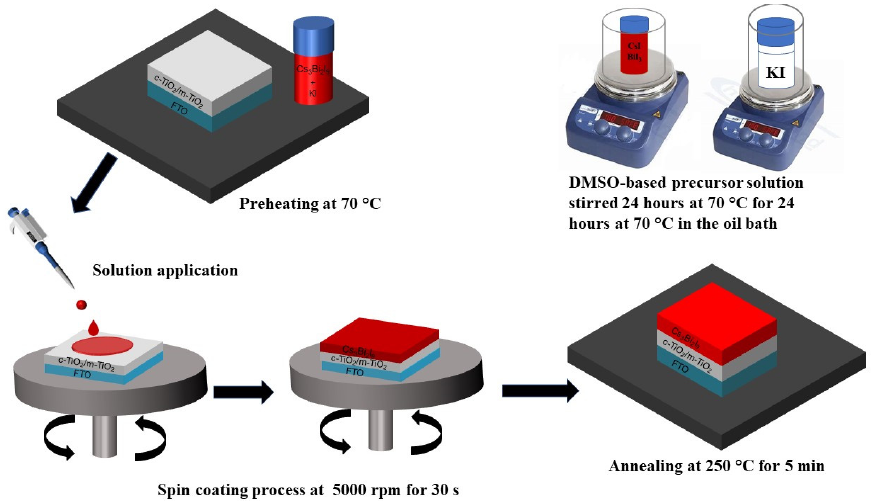
Figure 1. Schematic illustration of the conventional spin-coating process for preparing the Cs 3 Bi 2 I 9 and Cs 3 Bi 2 I 9 KI-incorporation devices.